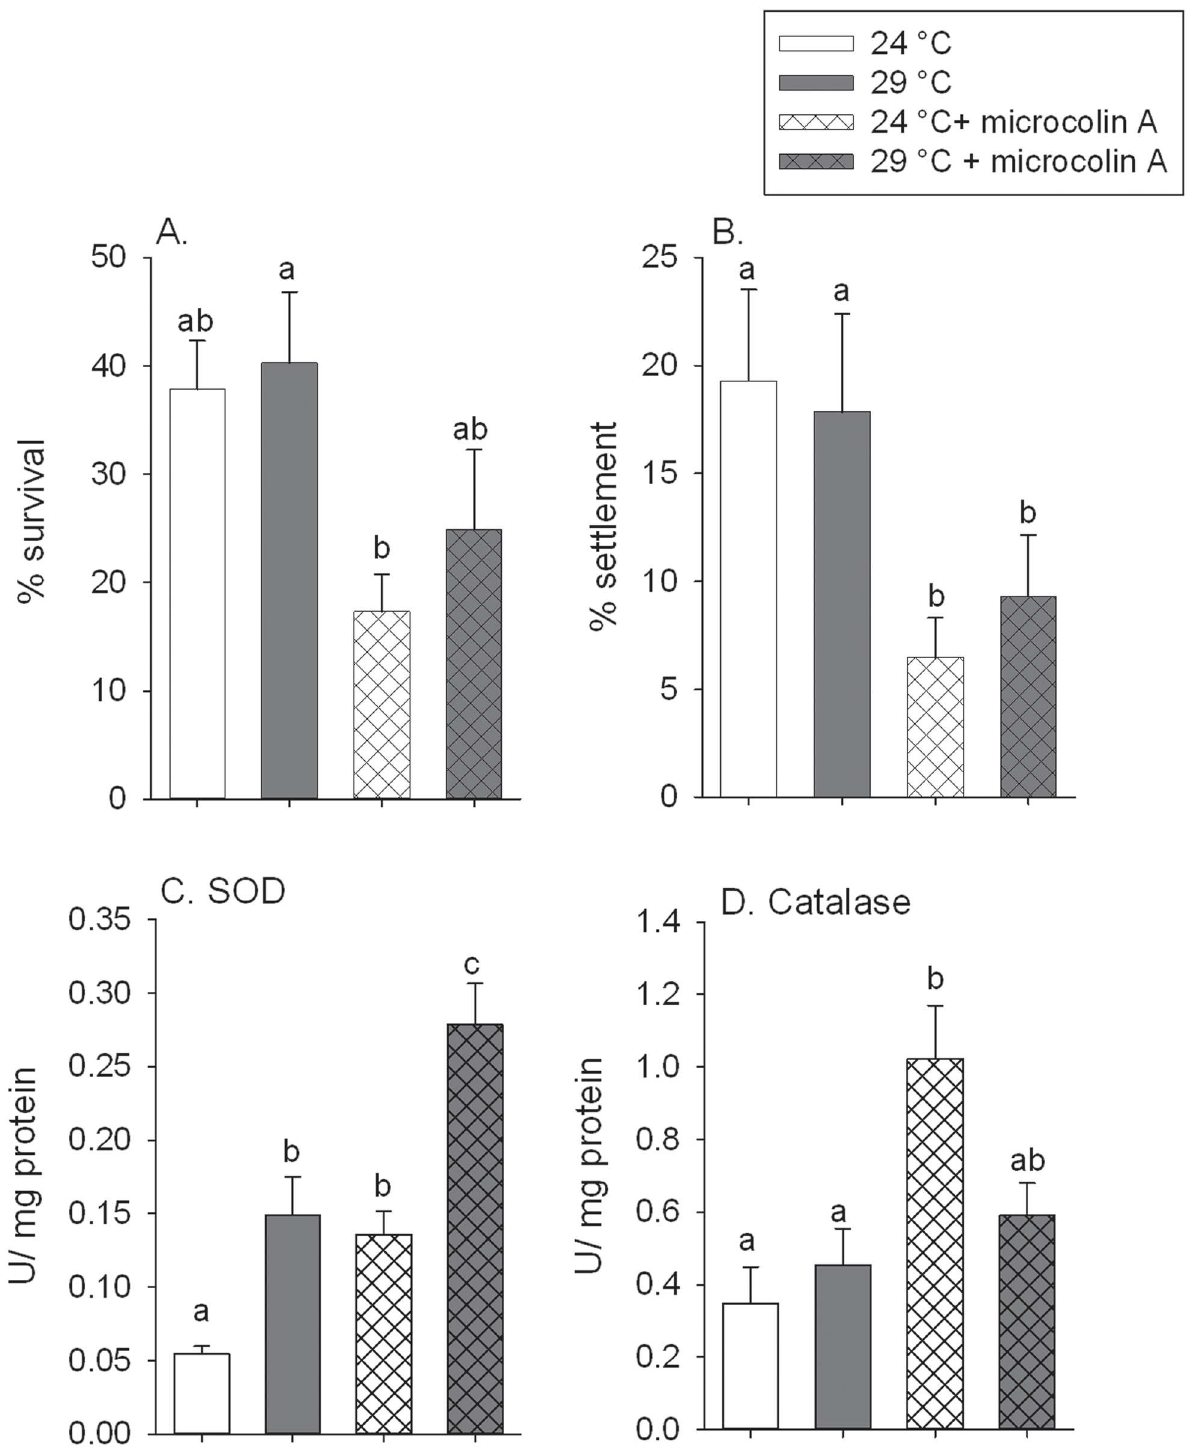
Fig 3. Experiment 1, larval exposure to sequential stressors,24 hour exposure to elevated seawatertemperatures followed by a six day exposure to microcolin A. Bars are untransformed means and error bars are +1 SE, sharedletters abovethe bars indicate means that are not significantly different. (A) The percent of larval survival and (B) the percent of larval settlement after exposureto stress. (C) The activity of superoxide dismutase (SOD) and (D) of catalase(CAT) in the swimmingcoral larvaeat the end of the experiment.